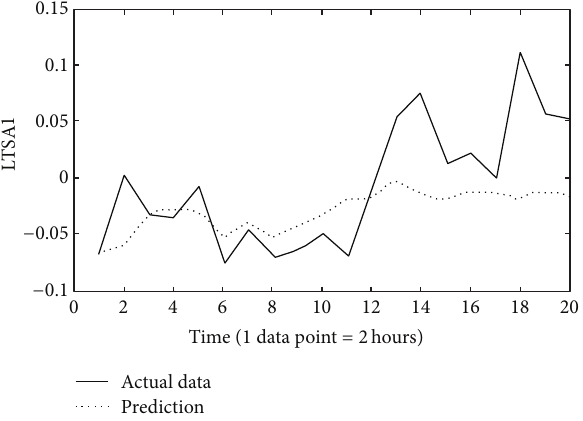
Figure 20: Selection of the embedding dimension by the CAO method of LTSA1.